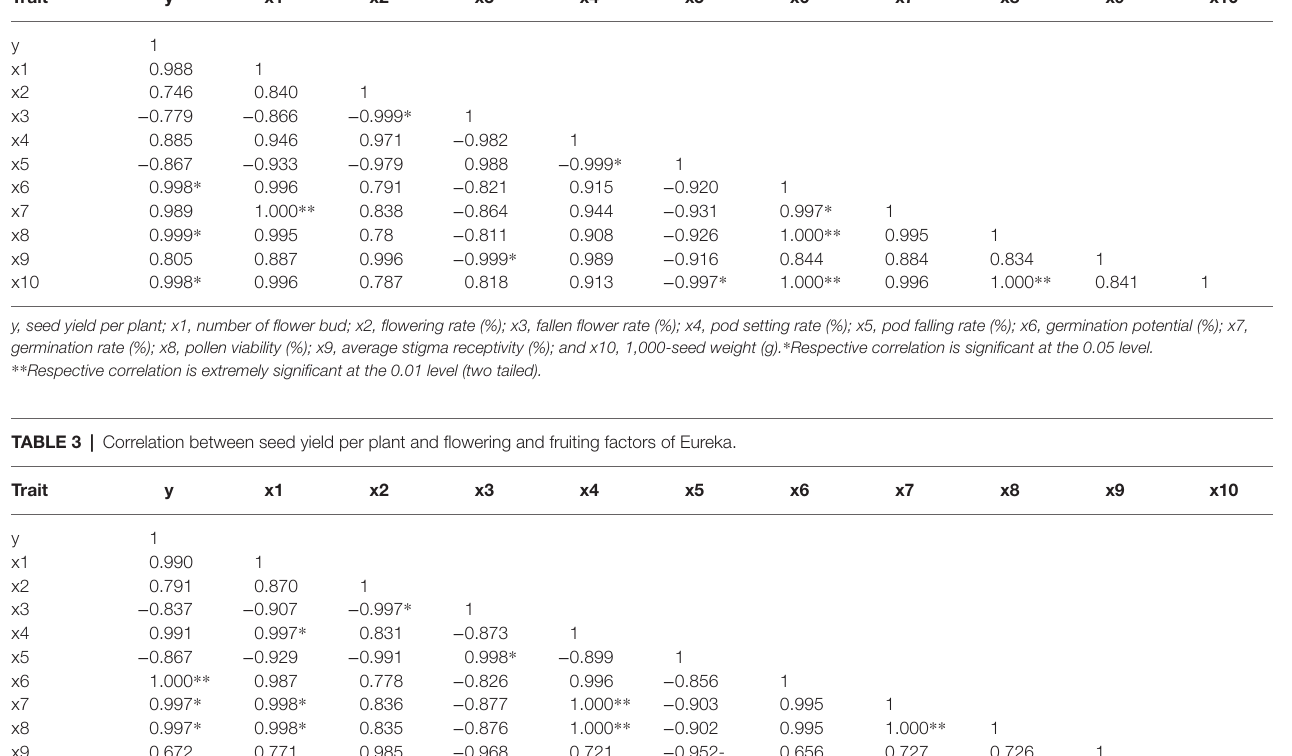
TABLE 2 | Correlation between the seed yield per plant and flowering and fruiting factors of Victoria. Trait